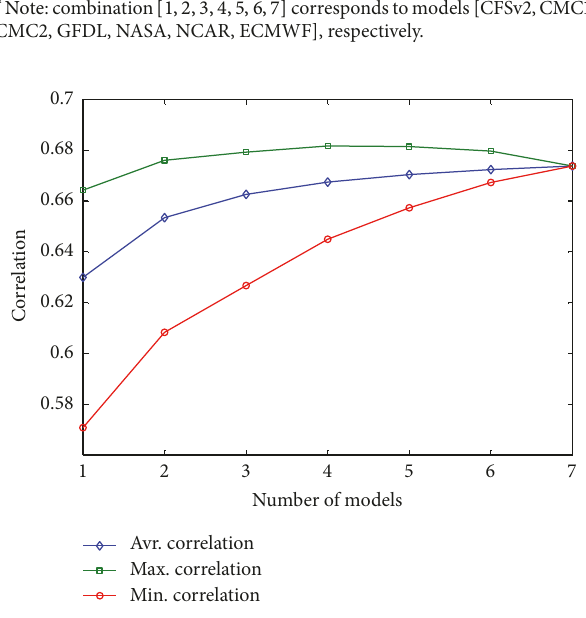
Figure 5: Combination analysis for average, maximum, and min- imum correlation for 1-month lead time precipitation between the models and the reforecast, as a function of the number of models in the ensemble in the northern part of the